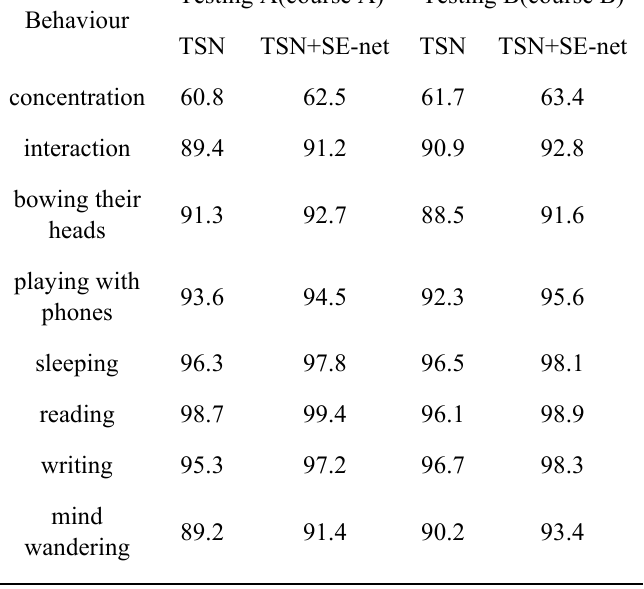
Table 3. Comparison of recognition accuracy between TSN and TSN+SE-net on real classroom